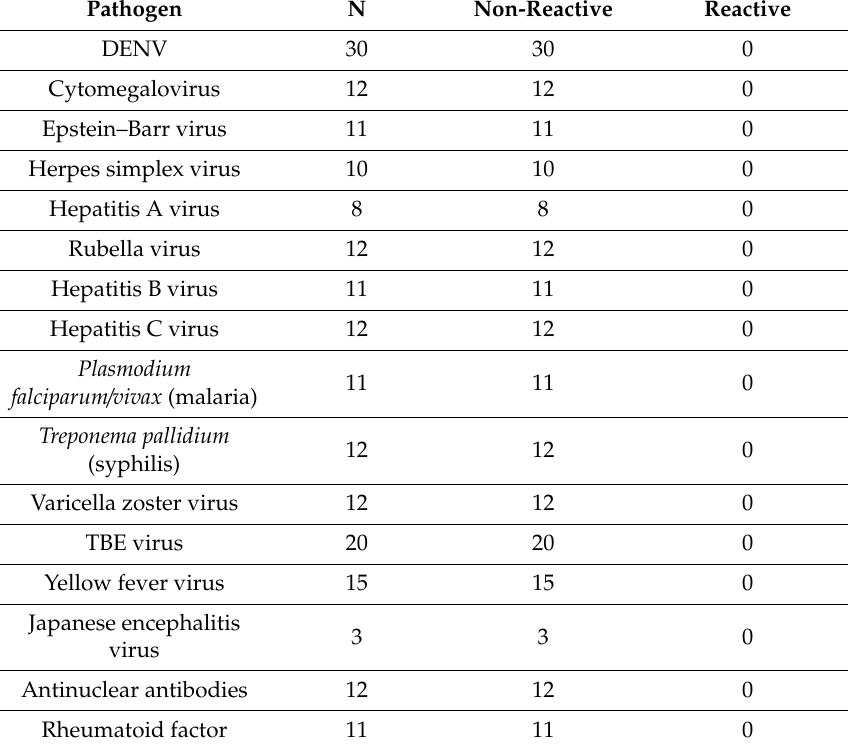
Table 3. Assessment of the Elecsys ® Zika IgG assay in potentially cross-reacting samples. Pathogen N Non-Reactive Reactive DENV 30 30 0 Cytomegalovirus 12 12 0 Epstein–Barr virus 11 11 0 Herpes simplex virus 10 10 0 Hepatitis A virus 8 8 0 Rubella virus 12 12 0 Hepatitis B virus 11 11 0 Hepatitis C virus 12 12 0 Plasmodium 11 11 0 falciparum / vivax (malaria) Treponema pallidium 12 12 0 (syphilis) Varicella zoster virus 12 12 0 TBE virus 20 20 0 Yellow fever virus 15 15 0 Japanese encephalitis 0 virus Antinuclear antibodies 12 Rheumatoid factor